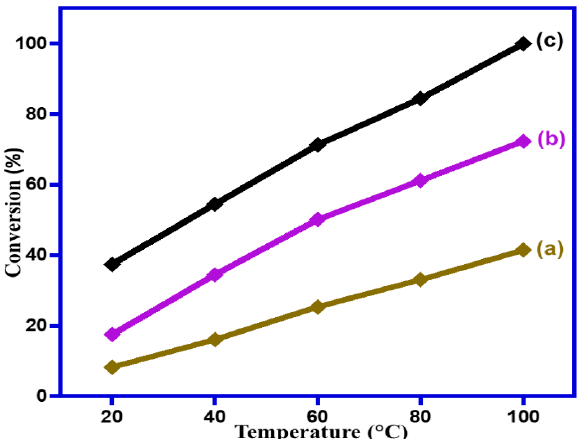
Figure 9. Impact of varying temperature on PhCH 2 OH conversion over ( a ) MnCO 3 , ( b ) MnCO 3 –(1%)ZrO 2 and ( c ) (1%)NDG/MnCO 3 –(1%)ZrO 2 catalysts.